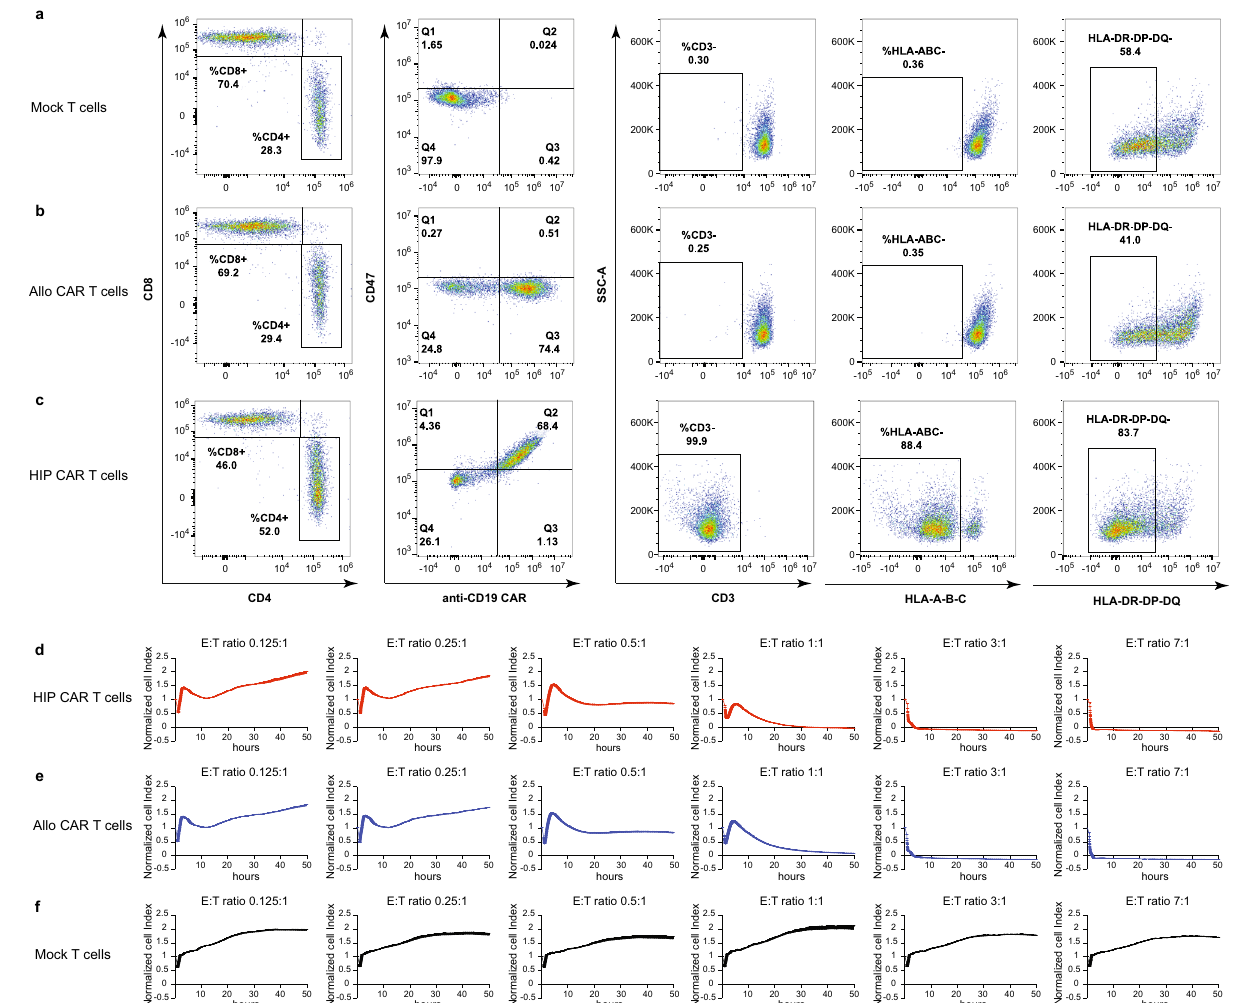
Fig. 1 | HIP CAR T cells are effective killers of Nalm6 tumor cells. a – c Flow cytometry of unedited (Mock, a ) T cells, anti-CD19 allo CAR T cells ( b ), and anti- CD19HIPCARTcells( c )areshown.Tcellsareidenti fi edbyCD4orCD8expression. Allo CAR T and HIP CAR T cells showed expression of the anti-CD19 CAR of approximately70%.HIPCARTcellsshoweddisruptionoftheTCR αβ /CD3complex